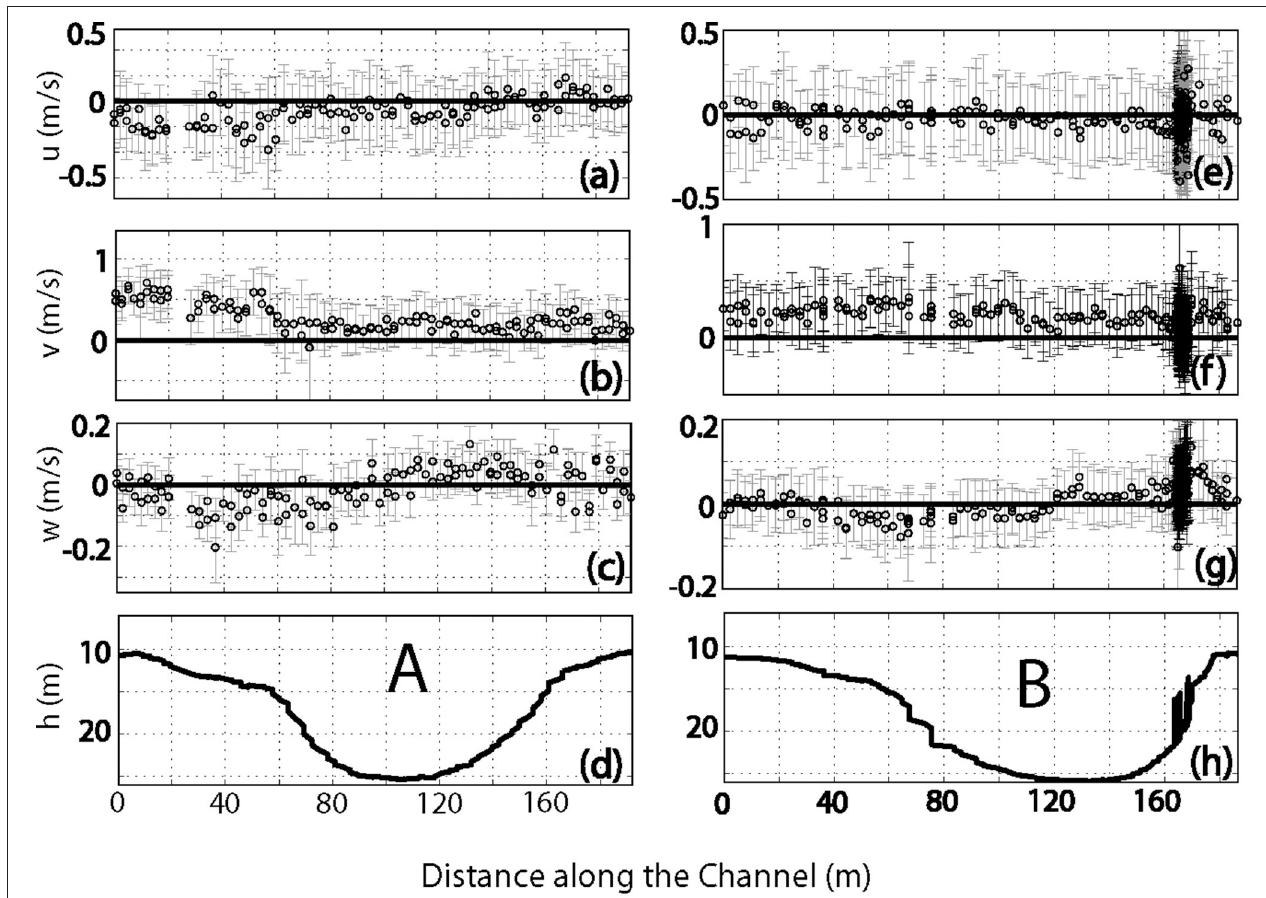
FIGURE 4 | Depth-averaged velocity for two of the second 6 transects, one over the northern scour hole. (A–D) are the eastward, northward, and upward velocity components and water depth profile, respectively, for the eighth transects (No. 8 in Table 1 ). (E–H) are the eastward, northward, and upward velocity components and water depth profile, respectively, for the tenth transects (No. 10 in Table 1